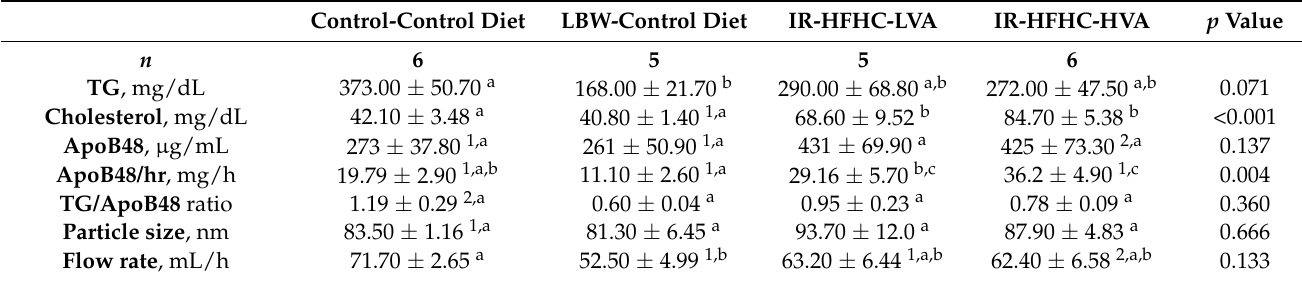
Table 5. Fasting lymph lipoprotein and lipid concentrations of control and LBW pigs fed control, HFHC-LVA, and HFHC-HVA